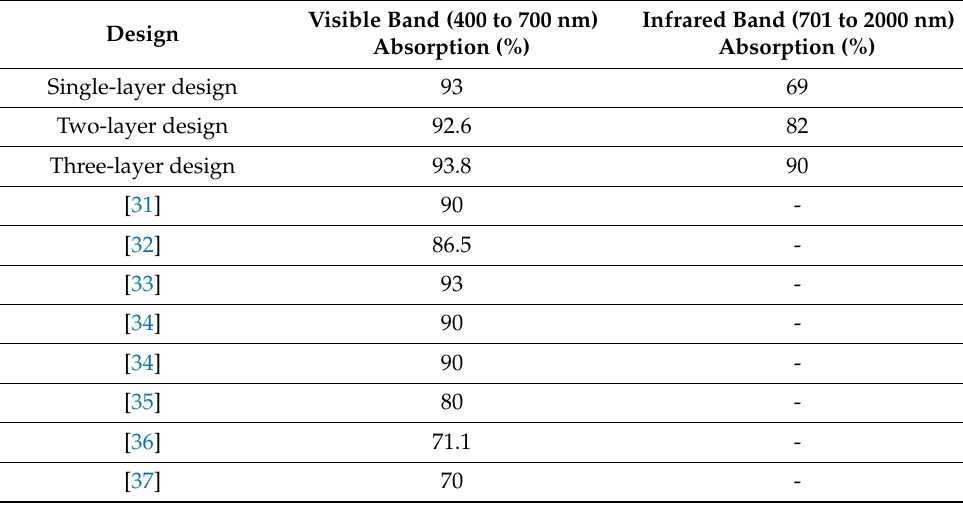
Table 2. Comparison of published solar absorber designs with proposed plus-shape metasurface